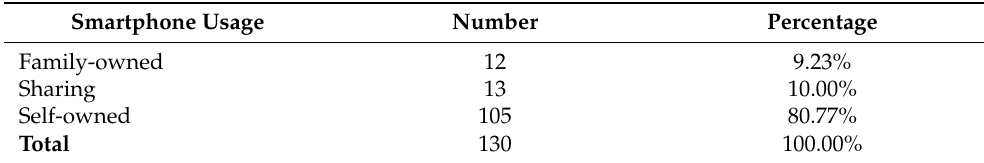
Table 3. The ownership of smartphones.